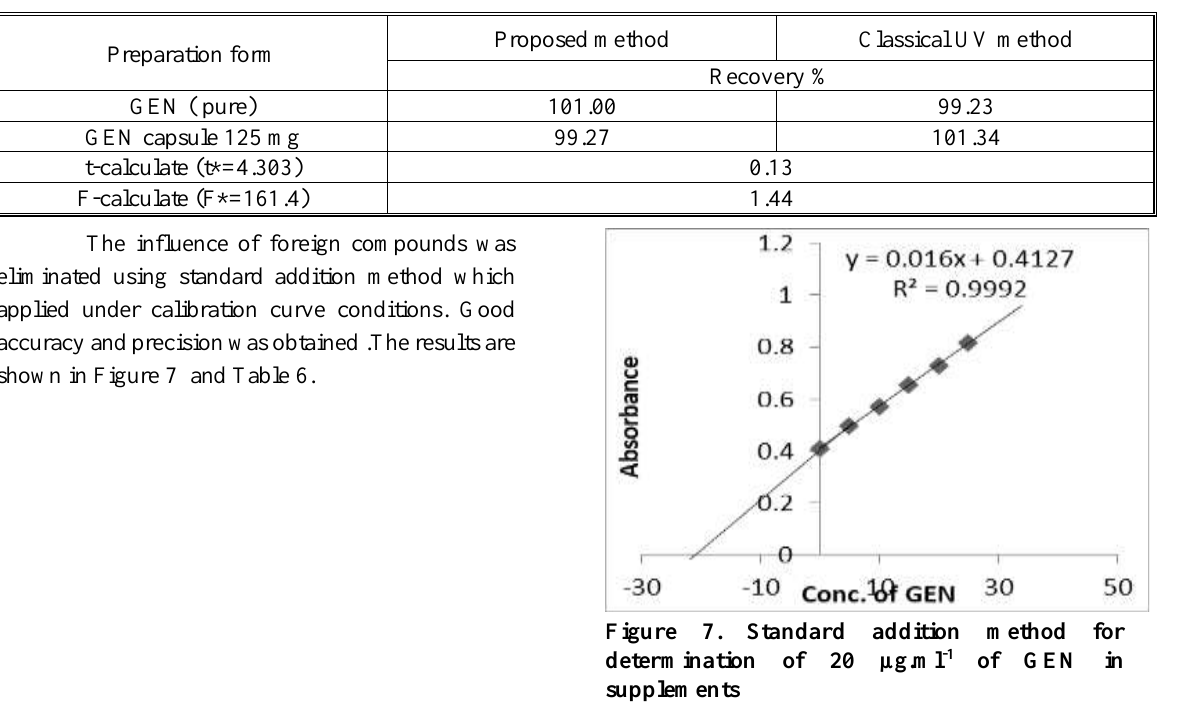
Table 5. The t- and F-tests were used to compare the proposed methods to the UV method